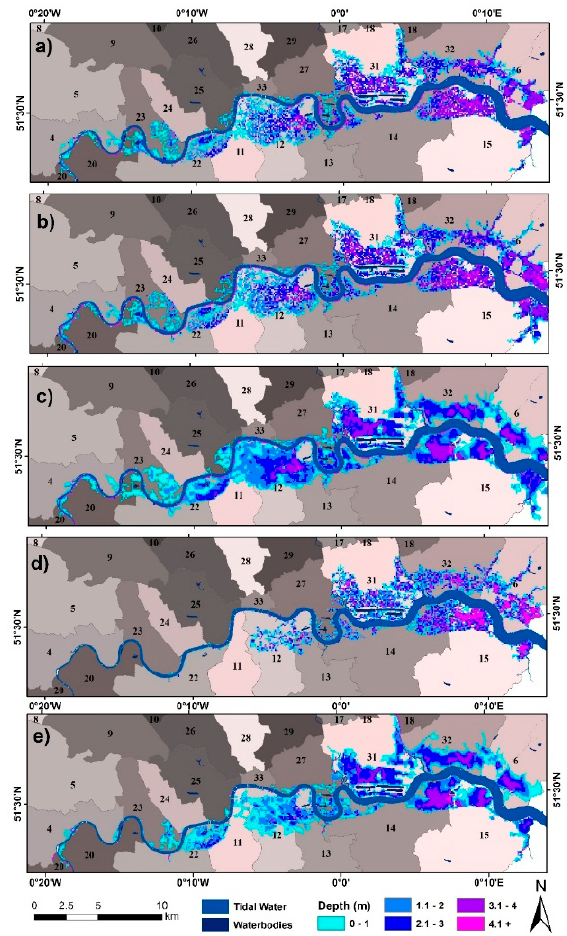
Figure 6. Flood depths obtained for inundated London boroughs from the eight-way hydrological connectivity approach by RCP8.5 global sea-level rise scenario of 0.82 m. ( a ) 1 m LiDAR DEM; ( b ) 5 m LiDAR DEM Re ; ( c ) 5 m DEM, ( d ) 30 m SRTM DEM; and ( e ) 50 m DEM. Figure 1 gives the borough names that correspond to the numbers.